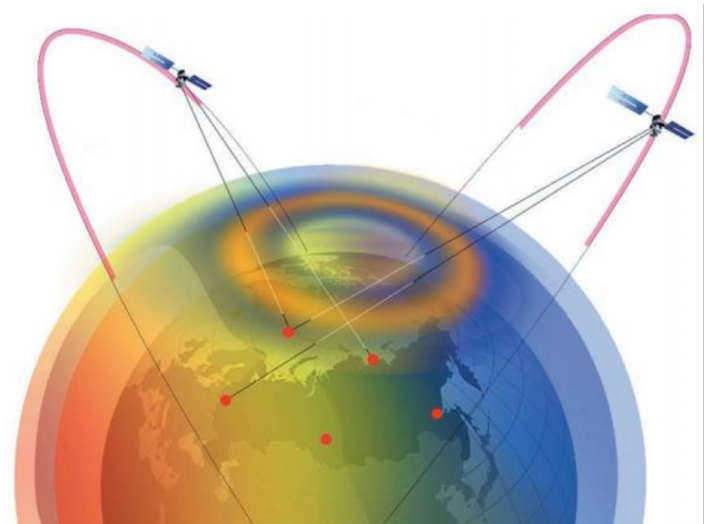
Figure 2. A common schematic diagram reflecting peculiarities of monitoring the ionosphere at the Arctic zone in the method of radio scanning from highly elliptical satellites. The working sections of the hydro-meteorological spacecraft orbits in the Russian project for environmental control in the Arctic “Arktika-M” are